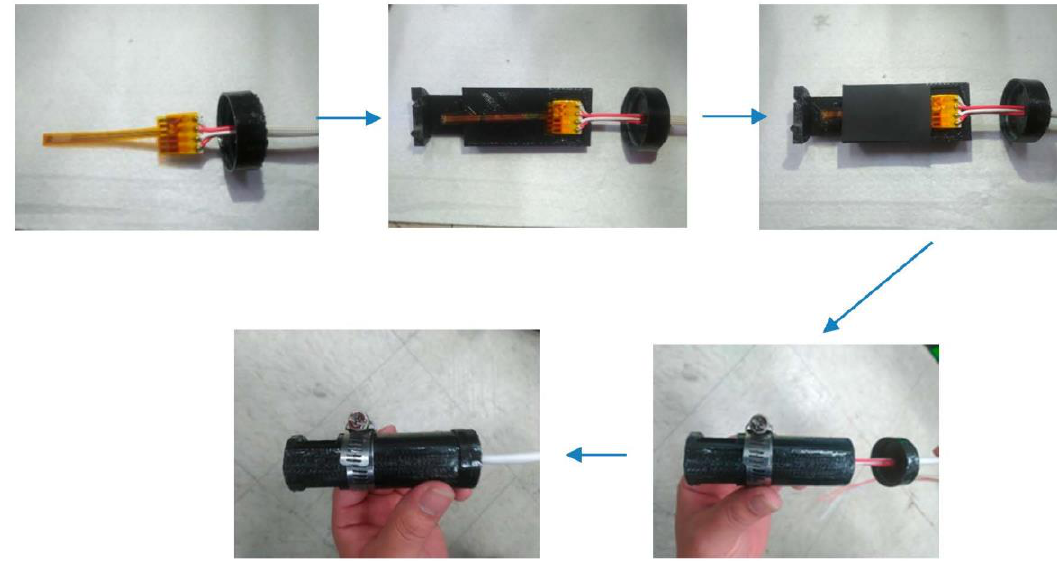
Figure 3. Packaging step.